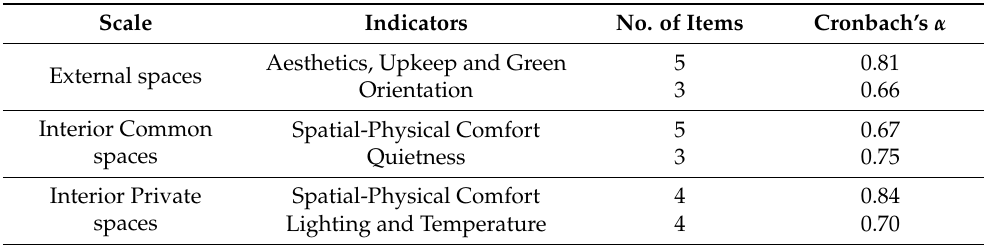
Table 1. Summary of the Hospice PHEQIs.